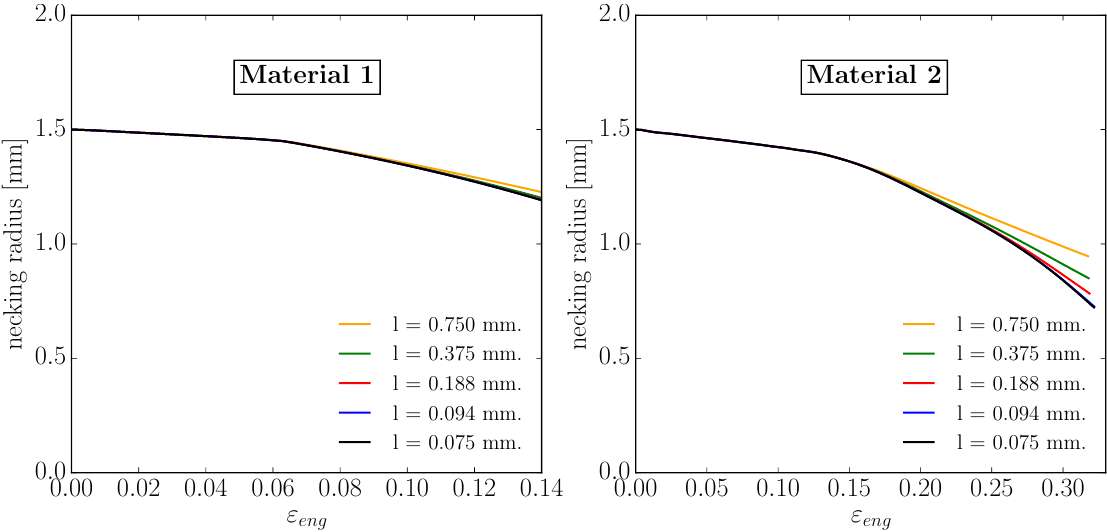
Figure 20. Load-strain curves of the 3mm-diameter specimen of both materials; comparison of meshes with different element sizes in the longitudinal direction at the necking region.